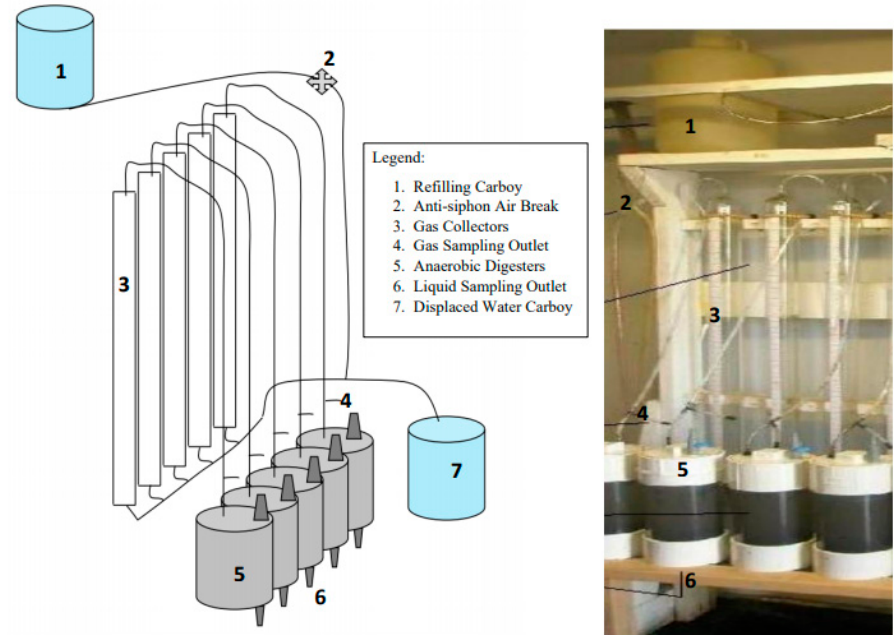
Figure 1. Experimental setup for the anaerobic digestion of biomass.